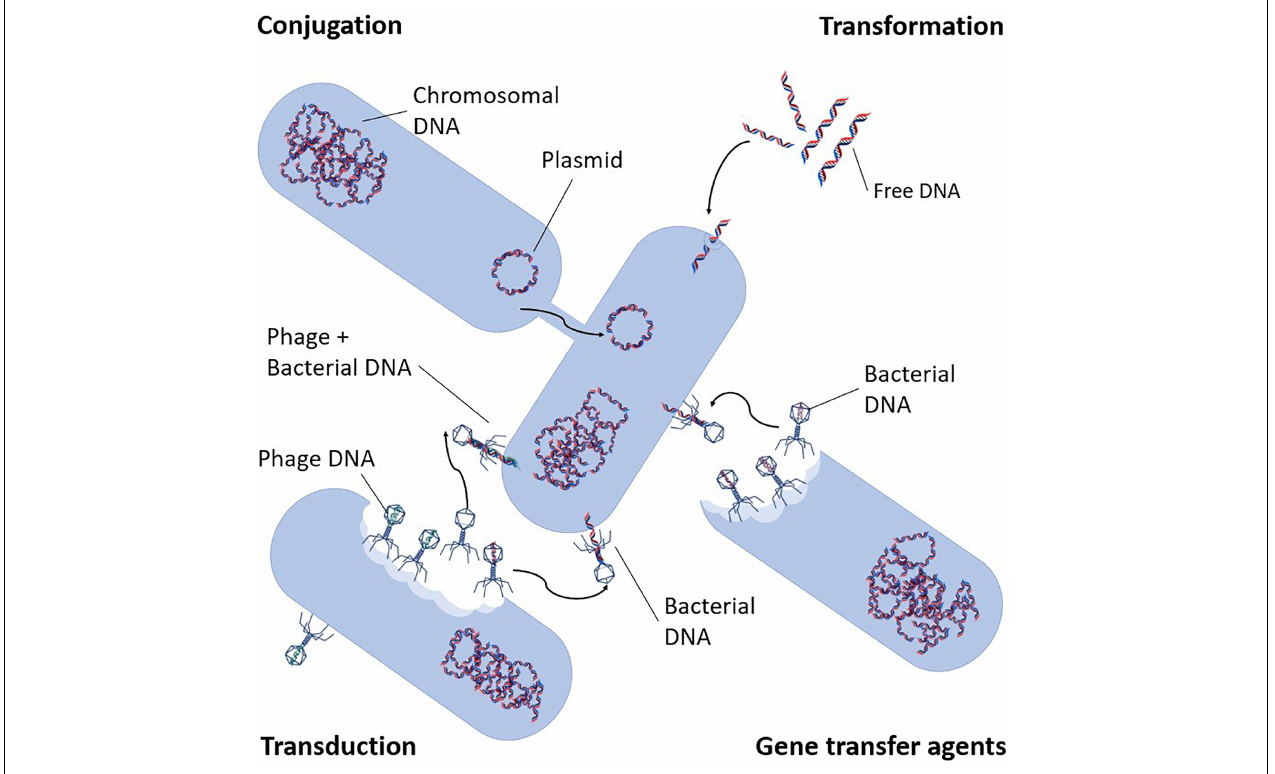
FIGURE 2 | Antibiotic resistance transport mechanisms (adapted from von Wintersdorff et al.,